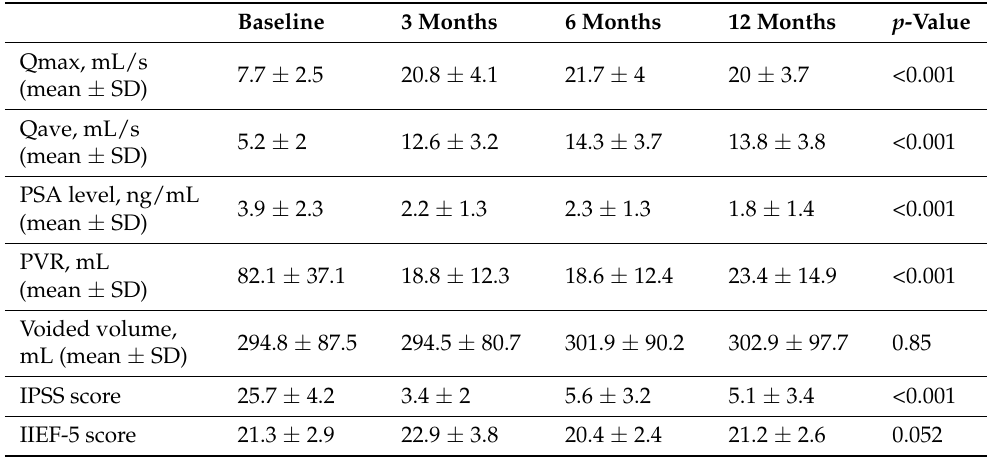
Table 4. Pre- and post-operative results at 3, 6, and 12 months after surgery. mL, milliliter; IPSS, International Prostatic Symptom Score; IIEF, International Index of Erectile